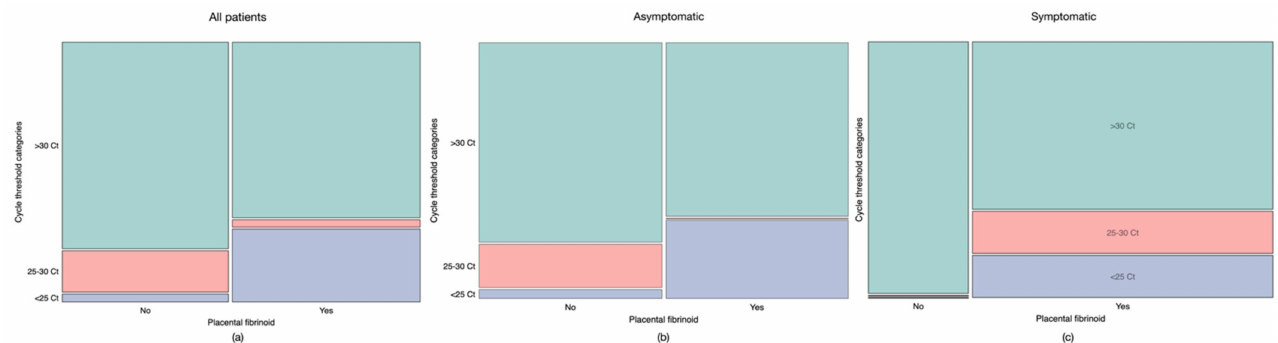
Figure 4. Presence of placental fibrinoid according to C T values. ( a ) all patients with a positive PCR test, ( b ) asymptomatic patients, ( c ) symptomatic patients. Lower C T values were more common in placentas from women who developed fibrinoid ( a ). asymptomatic patients who developed fibrinoid had either low or high C T s ( b ). All women with low C T values (<25), who were symptomatic, developed fibrinoid ( c